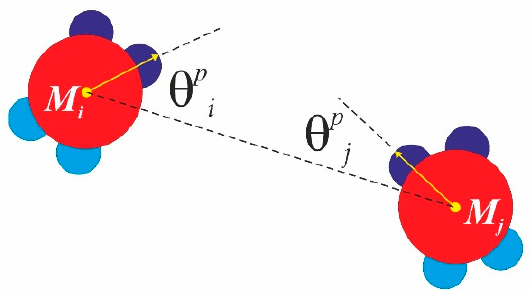
Figure 4. Minimal patchy angle for monomer M i and for monomer M j . These angles are used to evaluate the modulated Lennard-Jones (LJ) interaction potential between the monomers.